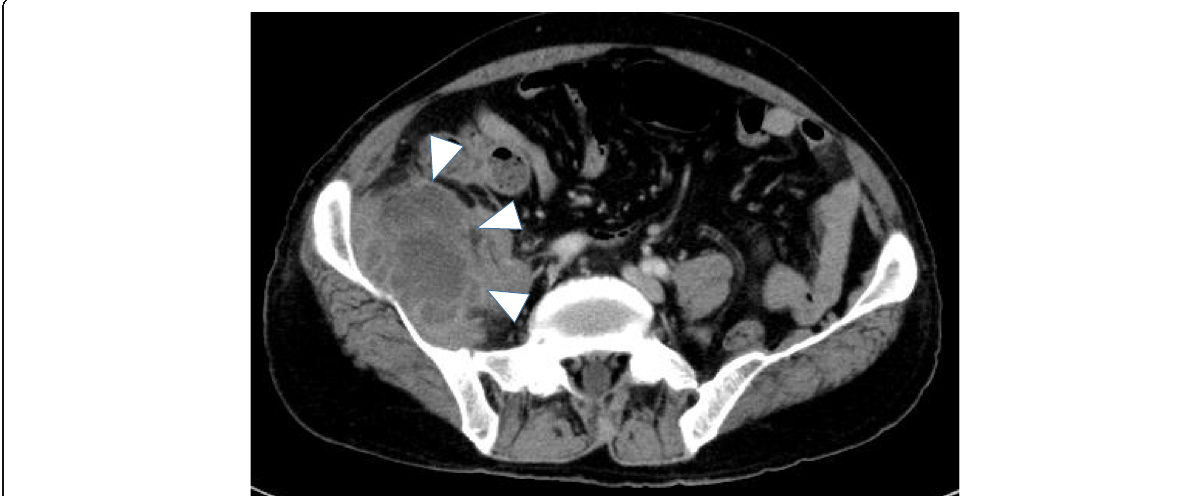
Fig. 1 CT image. Enhanced computed tomography revealed a heterogeneous contrast-enhancing mass lesion measured to be 55 × 50 mm in size at the lower right abdomen (white